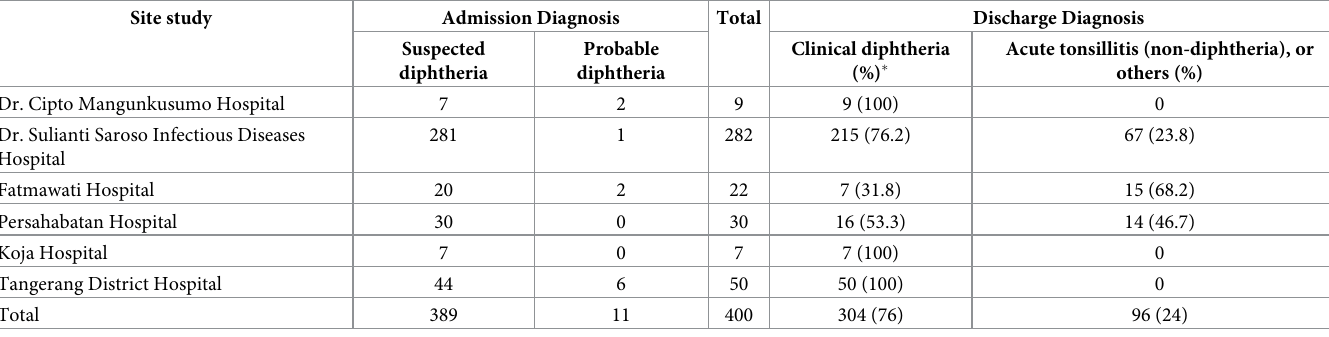
Table 1. Number of patients based on hospital.